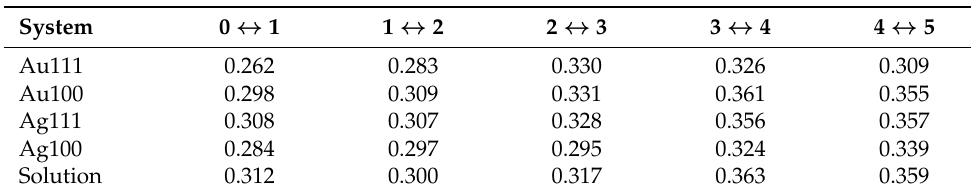
Table A1. Acceptance rates for REST simulations.